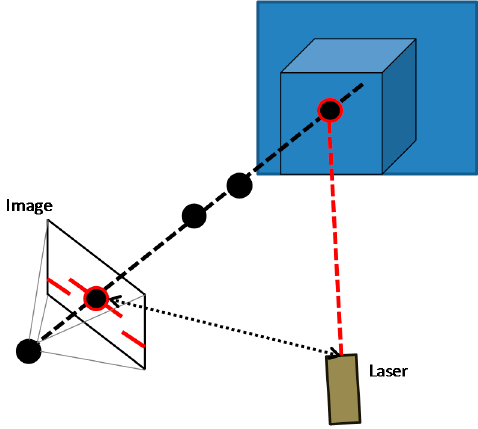
Figure 11. Laser Figure 11. Laser triangulation.